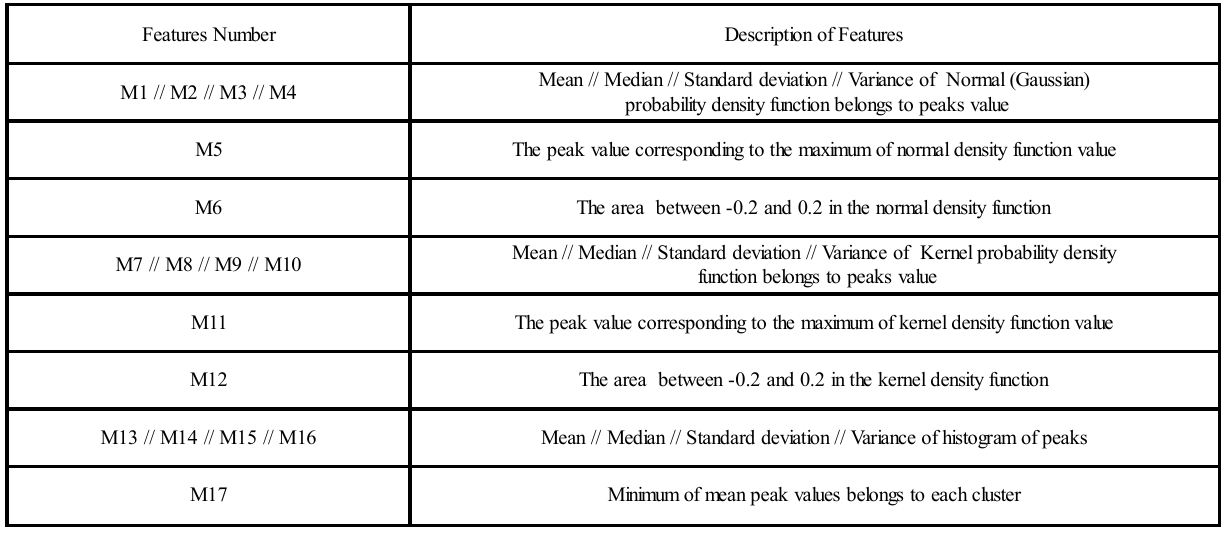
TABLE 3. SET-3: DESCRIPTIVE MODEL